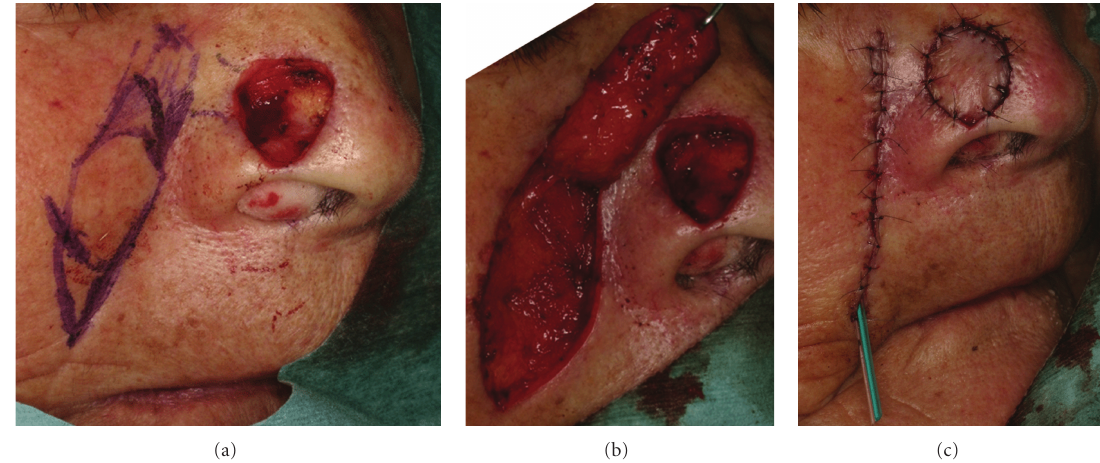
Figure 5: Nasolabial flap. (a) A flap is designed on the nasolabial fold. (This is permitted by Japanese Dermatological Association). (b) The flap is elevated in the subcutaneous plane. The flap is rotated and transferred to the defect. (This is permitted by Japanese Dermatological Association). (c) The skin defect of nasolabial fold was closed directly. (This is permitted by Japanese Dermatological Association).